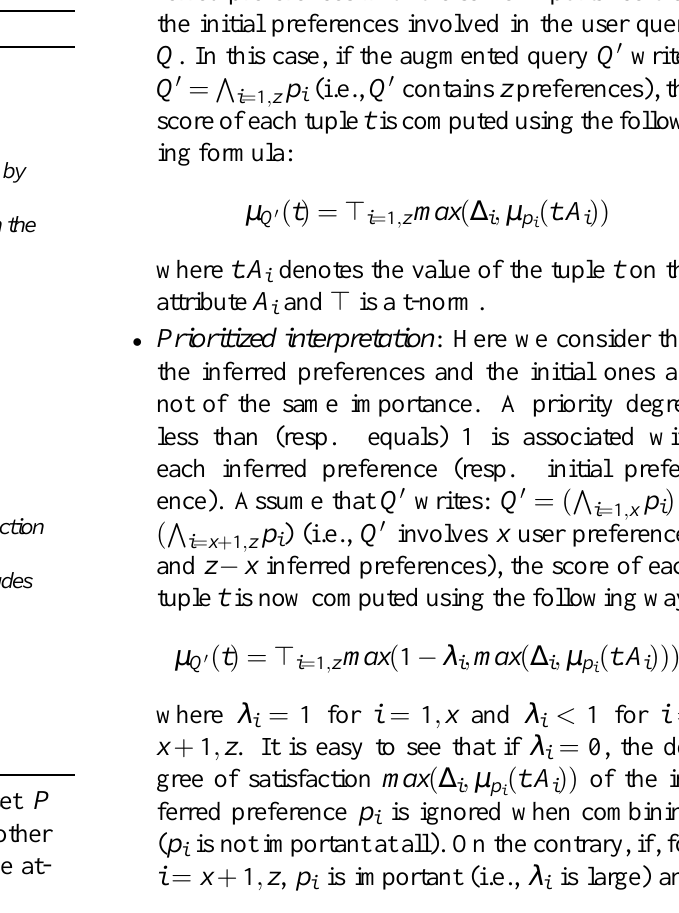
Algorithm 4: agg pre f